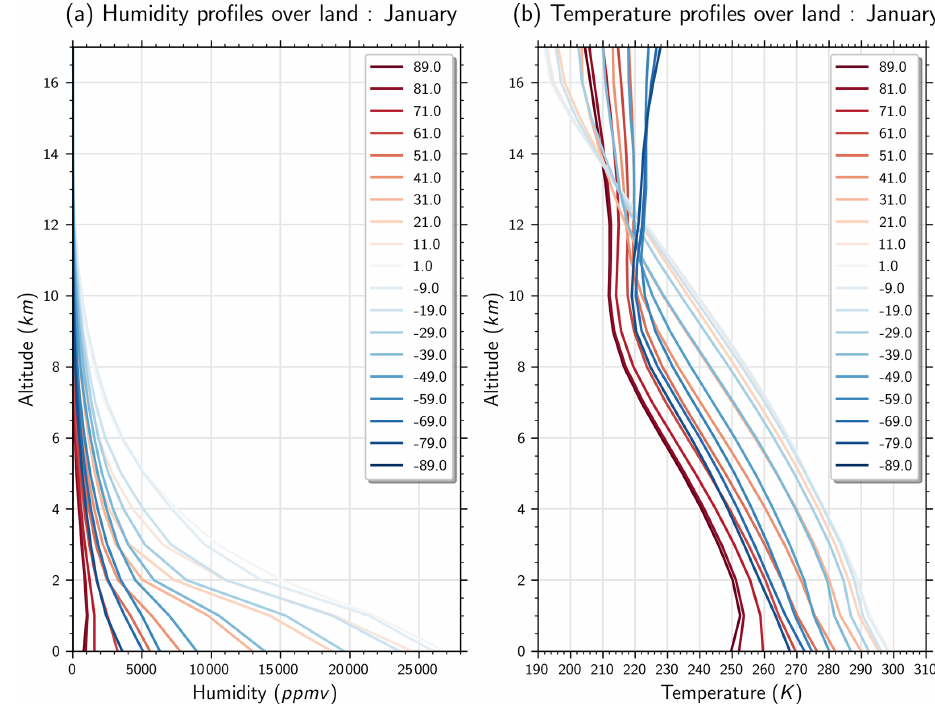
Figure A2. Example of ERA-Interim atmospheric profiles taken over land in January and averaged over 10 ◦ latitude